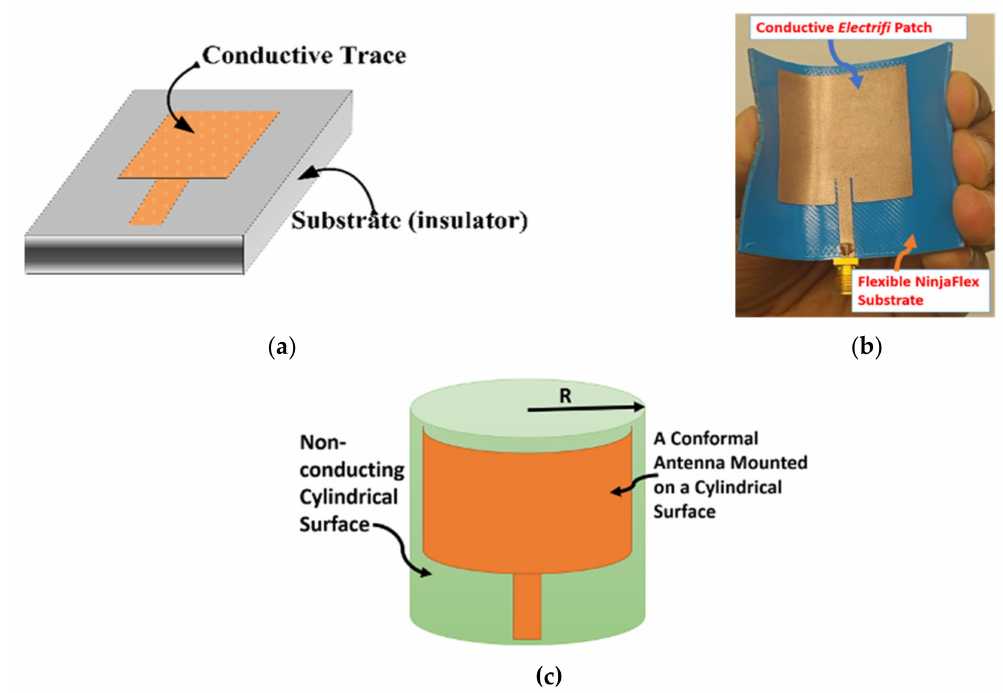
Figure 1. ( a ) A schematic of a microstrip patch antenna showing the conductive trace on an insulating substrate; ( b ) Electrifi based microstrip antenna on a 3D-printed flexible NinjaFlex substrate; ( c ) graphic depicting a patch antenna conformed on a nonconducting cylindrical surface of radius R